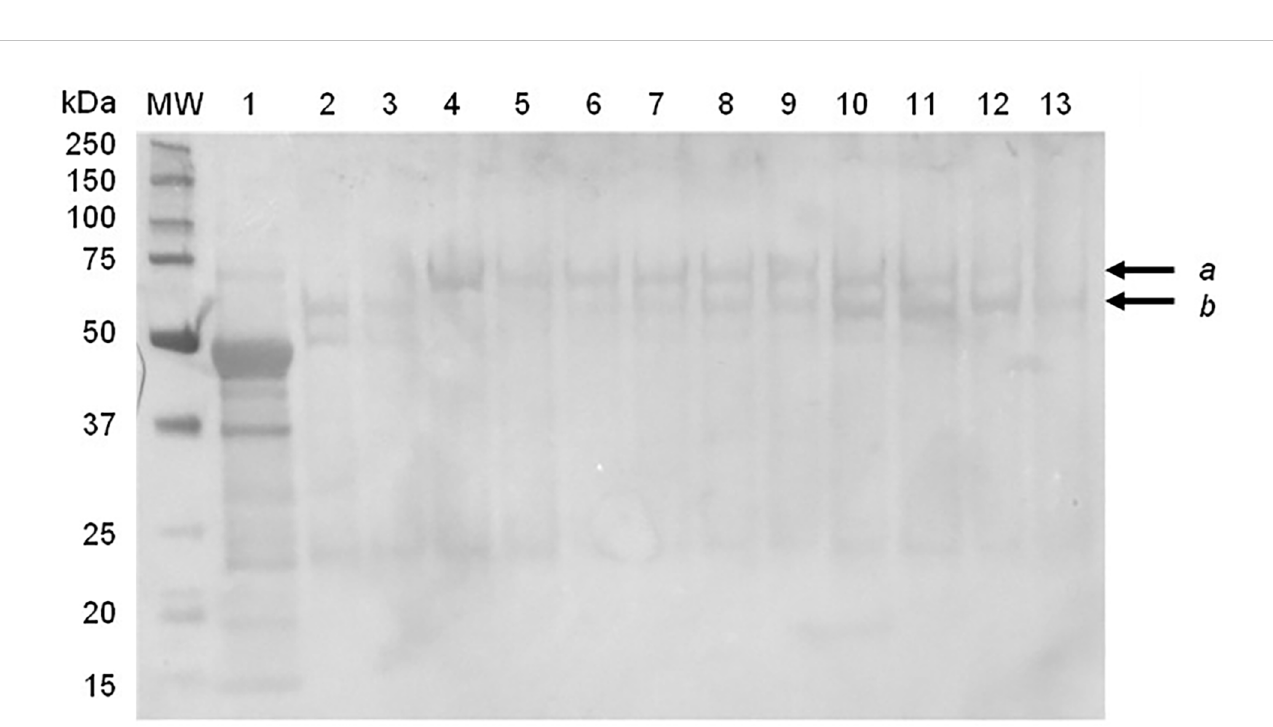
FIGURE 3 Immunoblot of partially puri fi ed plant-produce ND VLPs obtained with the co-expression of NDV Fusion (F), hemagglutinin-neuraminidase (HN) and/or Matrix (M) proteins, using NDV F1-speci fi c antibody. Lane 1: negative control – plant-expressed pEAQ-HT; lane 2: F alone; lane 3: F + M; lane 4: HN alone; lane 5: HN + M; lanes 6-8: F + HN + M; lanes 9-13: F + HN. Lane MW: The WesternC protein molecular weight marker was used. Arrows indicate the position of the (a) HN (approximately 62 kDa) and (b) F (approximately 56 kDa)